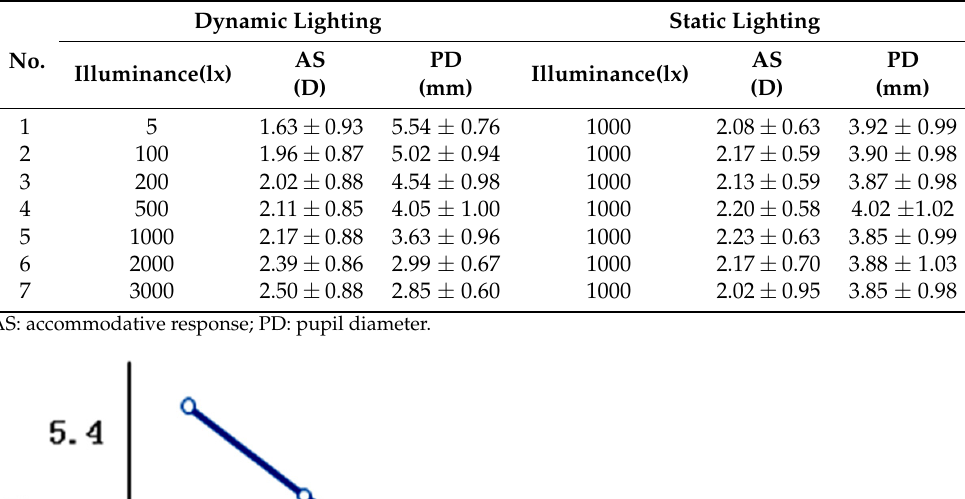
Table 2. Effects of dynamic lighting and static lighting on accommodative response and pupil diameter.